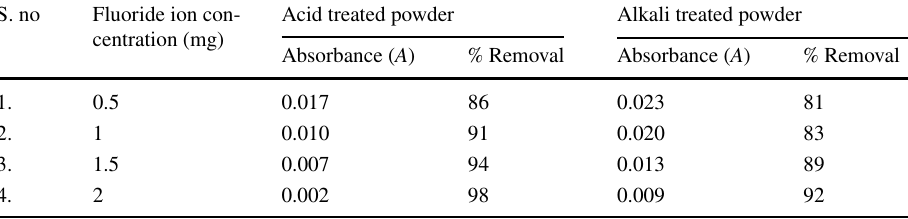
Table 4 Effect of fluoride